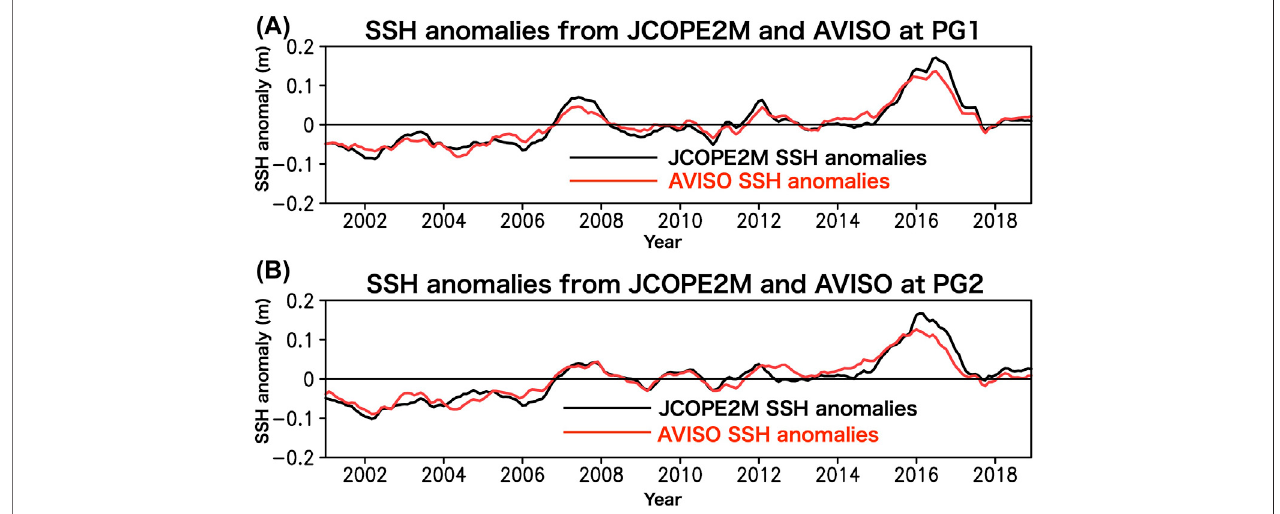
FIGURE 2 | (A) Timeseries of the JCOPE2M SSH anomalies (black thick solid line) and the observe altimetric AVISO-SSH anomalies (red thick solid line) at PG1 (indeed,theclosestgridpointtothelocationofPG1,i.e.,41.625 ° N,144.375 ° E).Theunitism. (B) Sameas (A) butatPG2(indeed,theclosestgridpointtothelocationof PG2, i.e., 42.125 ° N, 144.875 °